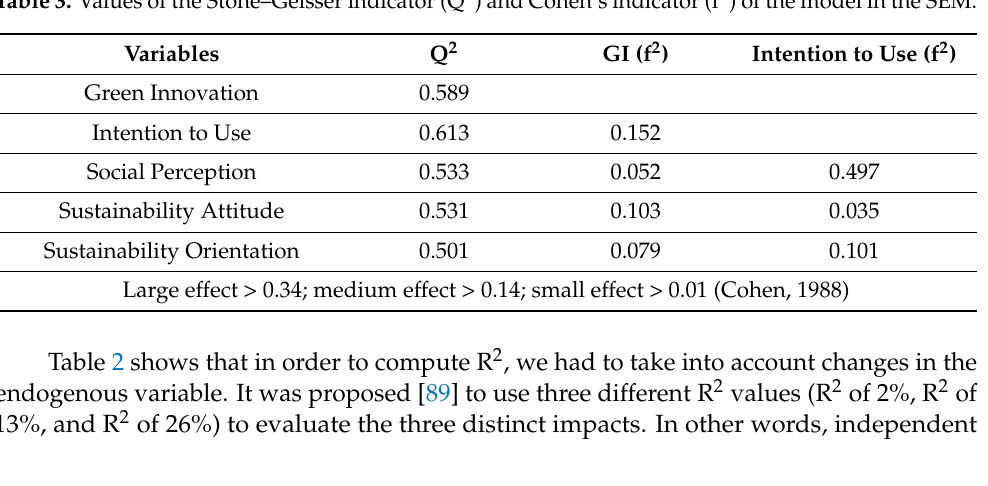
Table 3. Values of the Stone–Geisser indicator (Q 2 ) and Cohen’s indicator (f 2 ) of the model in the